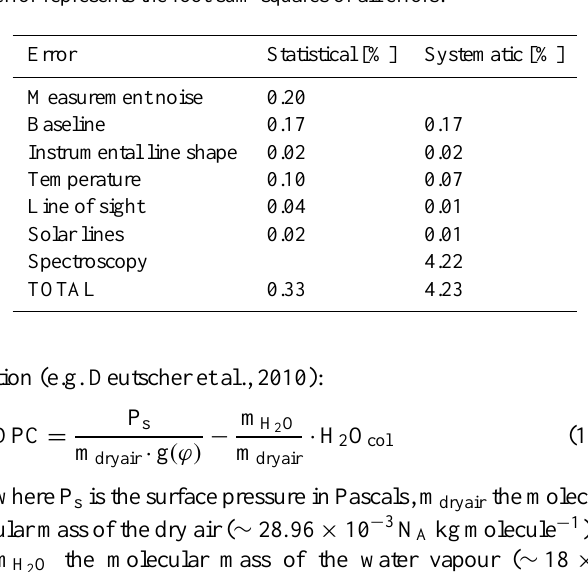
Table 3. Statistical and systematic errors in the Karlsruhe total CO 2 - column due to the assumed uncertainty sources of Table 2. The total error represents the root-sum-squares of all